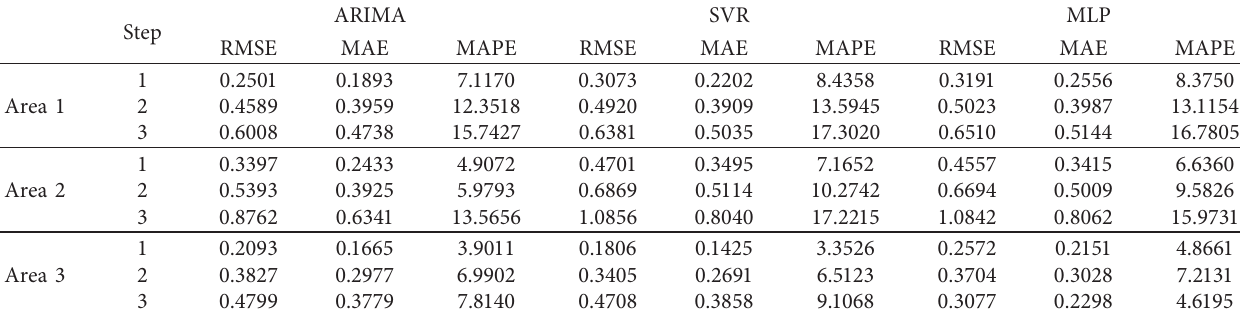
Table 6: Comparison of the proposed model and other models (a).